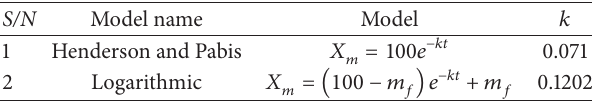
Table 3: Mathematical models applied to drying